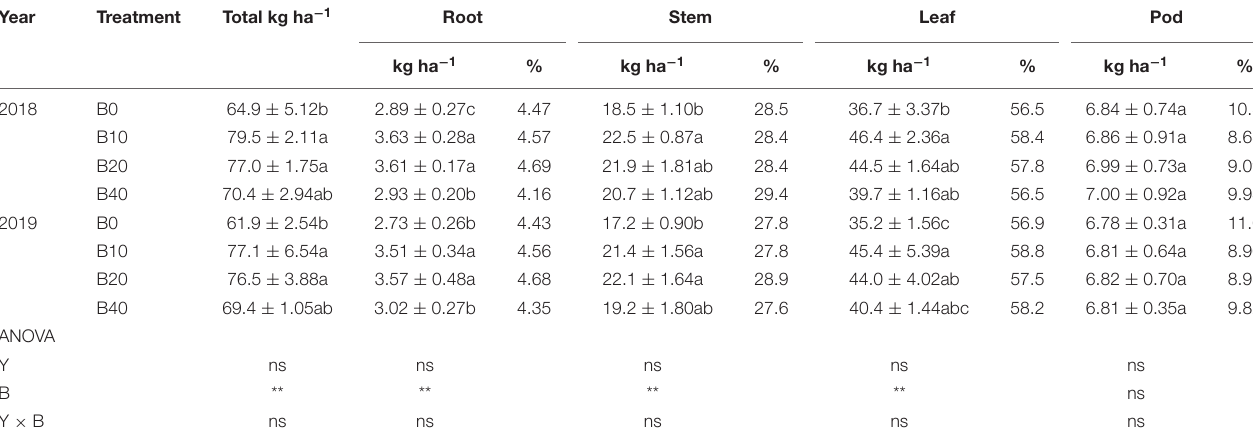
TABLE 2 | Nitrogen accumulation and distribution at the flowering in peanut with four rates of biochar in the 2018 and 2019 growing